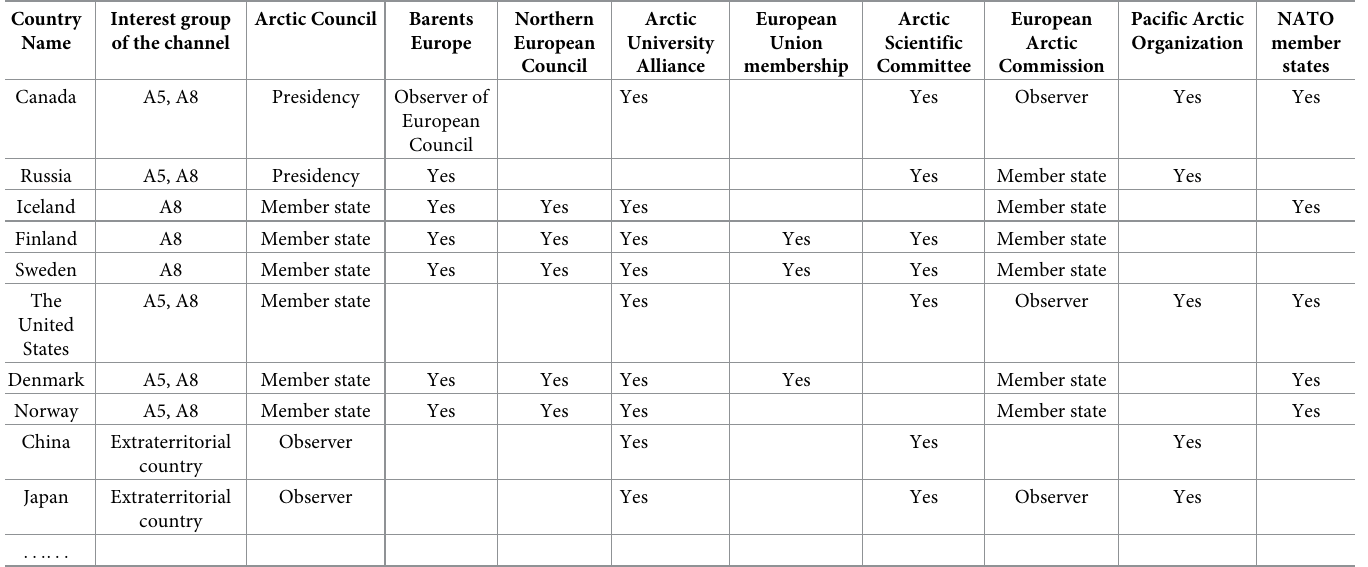
Table 4. Geopolitical features of the Arctic Passage. Country Interest group Arctic Name of the channel